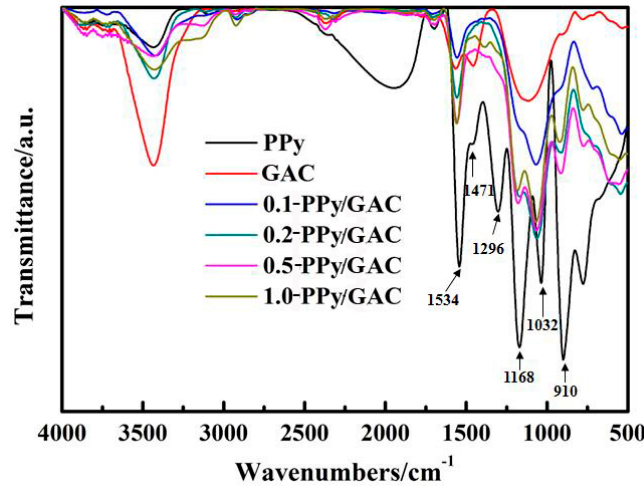
Figure 2. FT-IR spectra of the prepared adsorbents.